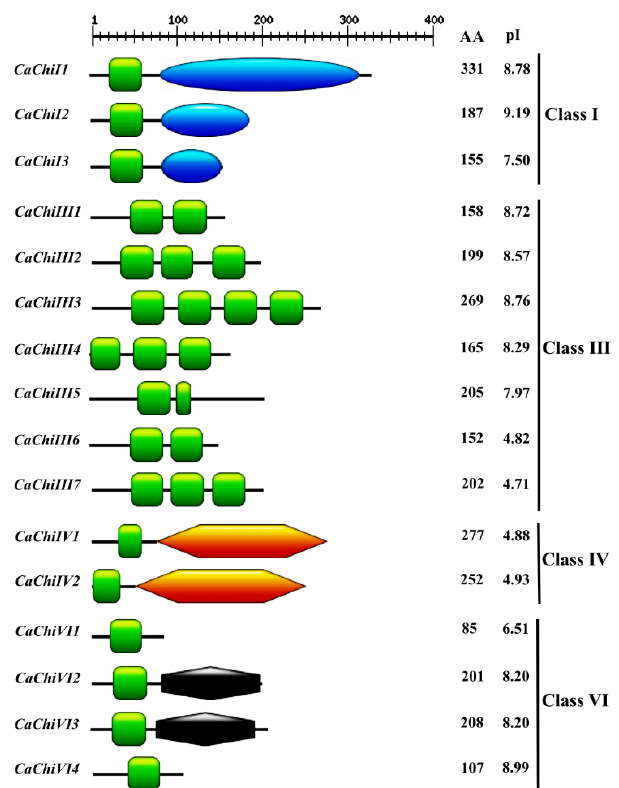
Figure 1. Domain architecture of CaChi classes I–VII in pepper and other plant species. The logos of domain